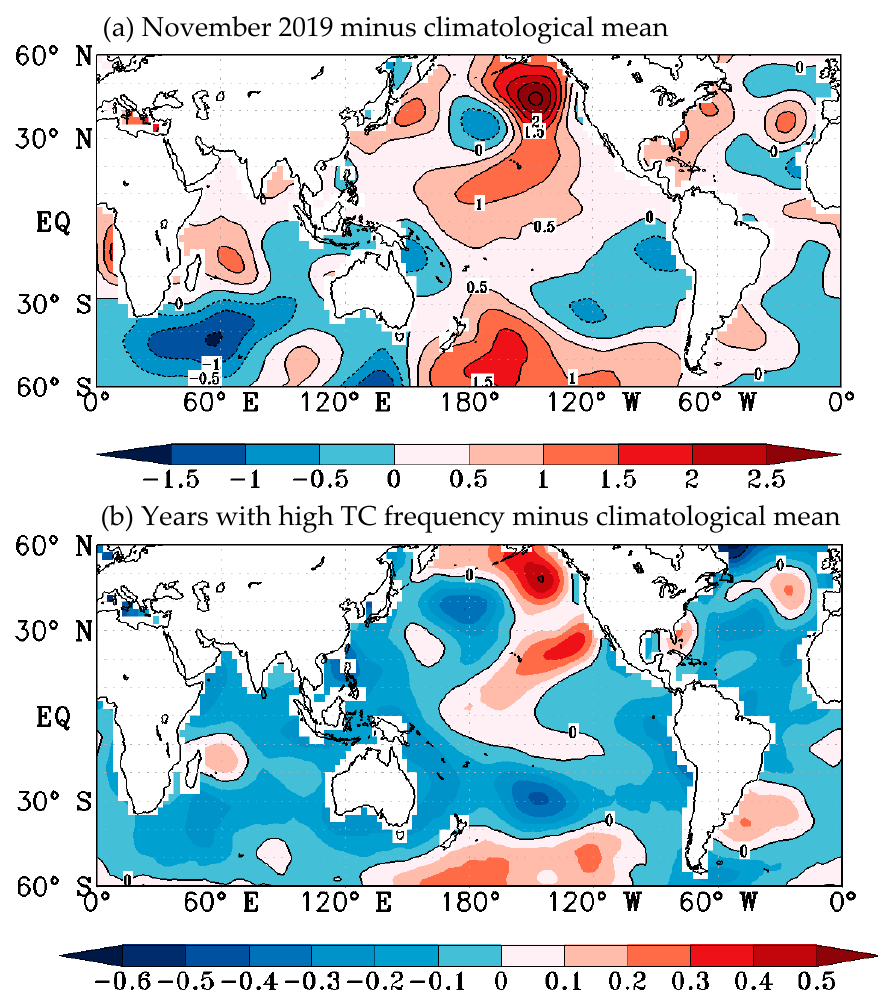
Figure 8. SST anomalies for ( a ) November 2019 minus the climatological mean and ( b ) the years with high TC frequency minus the climatological mean.